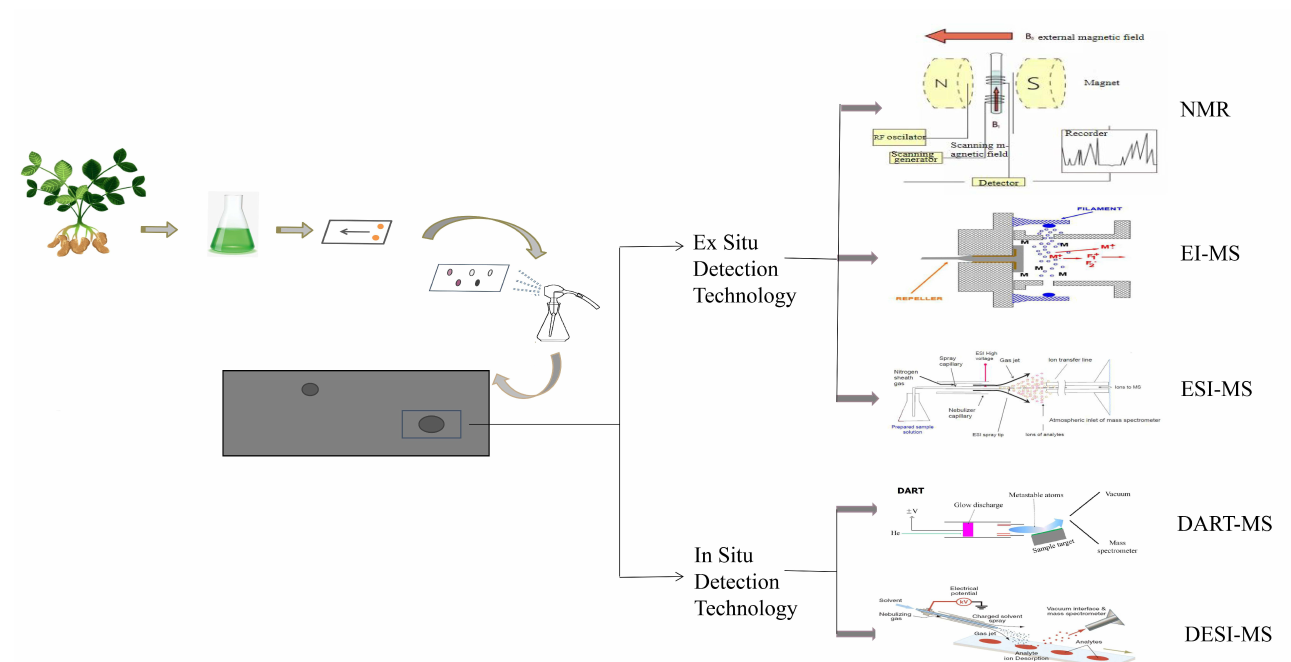
Figure 3. Principle of different detection methods coupled with TLC bioautography. Novel bioautography uses a variety of detection techniques, mainly including ex situ and in situ. the former mainly includes nuclear magnetic resonance (NMR), electron ionization mass spectrometry (EI-MS) and electrospray ionization mass spectrometry (ESI-MS); the latter primarily contains direct analysis in real-time mass spectrometry (DART-MS) and desorption electrospray ionization mass spectrometry